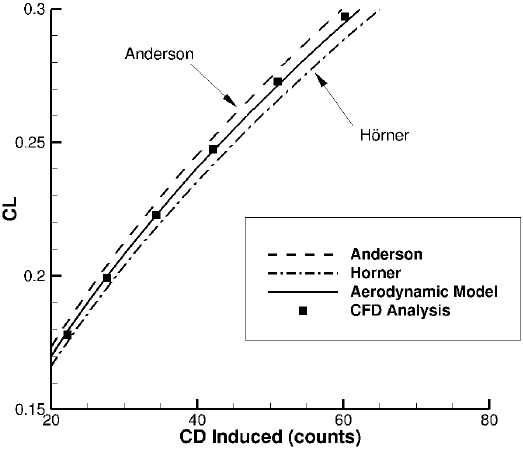
Figure 8. Lift-induced drag formulation for swept wings.